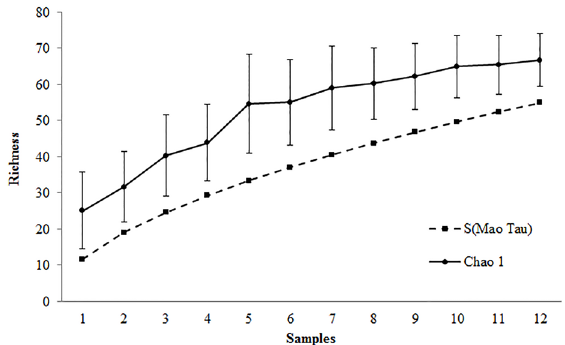
Figure 2 - Rarefaction analyses comparing ant assemblages sampled in four PPA sites (Guatambu (GUA) and Caxambu do Sul (CXS) in Santa Catarina, and Rio dos Índios (RI1 and RI2) in Rio Grande do Sul), in the Foz do Chapecó hydroelectric power plant lake area (January